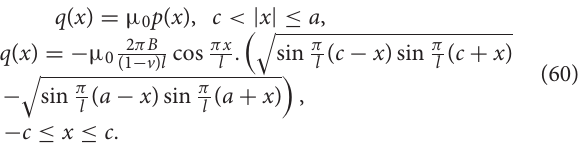
0.25, Q / P 0.15 and (B) µ 0 = =